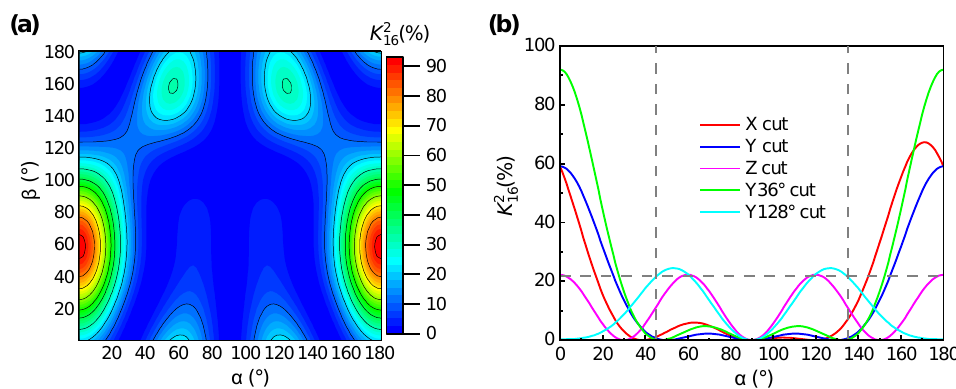
Figure 2. ( a ) The contour plot of K 2 orientations for LN under different propagation angle α .